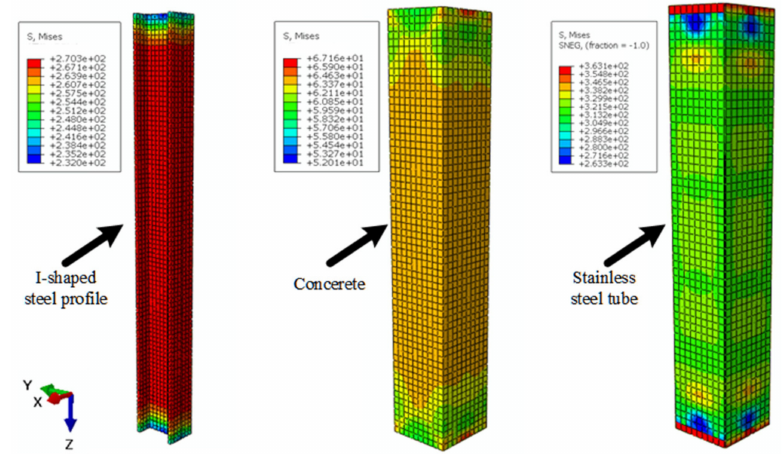
Figure 12. Cloud chart of stress development of each part under same axial load.